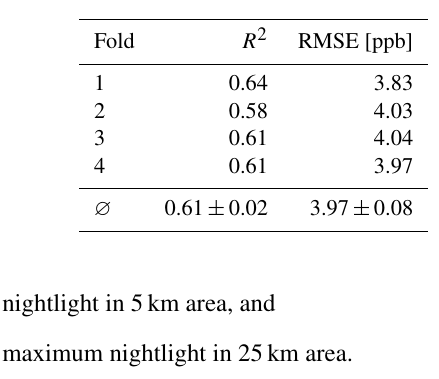
Table 4. Four-fold cross-validation